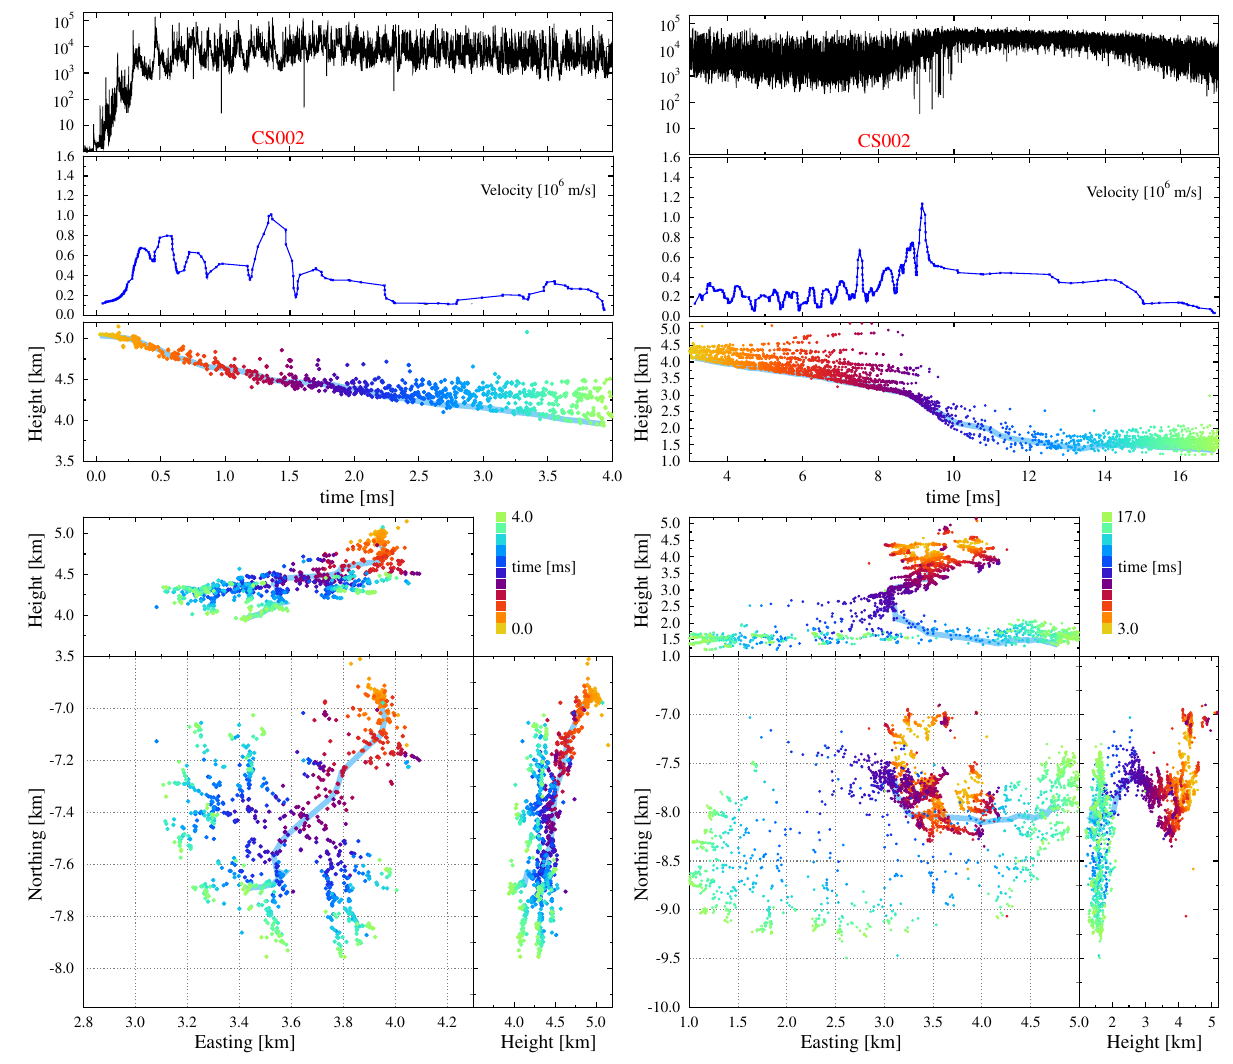
Figure 4. Same as Fig. 3 but for the initial parts of flash B, where the panels from top to bottom show the time trace, the velocity along a predefined track, and the altitude of the sources, all v.s. time. The bottom panels show different projections of the source positions. The predefined track is indicated by a light blue band. The left side of the figure shows the sources for the 4 ms of the flash, while the right for the subsequent 13 ms. The right side shows the sources on a more zoomed-out scale than the 2 the second one covered an area of 2 × 3 km at an altitude of only 1.5 km. The first IRNL, during the initial stage of the flash, show 6–7 high-power VHF pulses during the first millisecond, similar to what is seen in Flash A. Most interesting is that the IRNL mode is not confined to the initiation region but may occur during the later development of the flash and appears to be linked to a particular spot in the atmosphere. The left-hand panel of Fig. 5 gives a zoom-in of Flash B around the time a strong signal was recorded by the broadband antenna and showing another IRNL from t = 274 till 280 ms. This figure shows two negative leaders that were propagating eastward, and then seemed to stop propagating, the first one, marked by the green box, at t = 272 ms at an alti- tude between 0.5 and 1.0 km and the second, marked by the yellow box, slightly later at t = 274 ms between (N = 10 km, E = 9–10 km) while propagating upward towards an altitude of 2 km. A bit later, after the strong 11 to − − pulses in the broadband antenna, around t = 279 ms the second negative leader seemed to re-appear in a broad semi-circle with a radius of about 3 km centered around the position where the second disappeared (indicated by the yellow arcs), to resume normal negative leader propagation. A few filaments can be distinguished in-between where the leader “disappeared” and resumed propagating. Based on the distance and time, the negative leader 6 must have reached speeds of 10 m/s when it was poorly imaged. During the same time span there is a strong increase in the emitted VHF power in the form of a very noisy, amorphous, structure with several short duration spikes superimposed on top. With the exception of the upper left, north-east, corner, no previous leader activity has been seen in the area depicted in Fig. 5. This is an archetypical example of an IRNL mode of propagation.